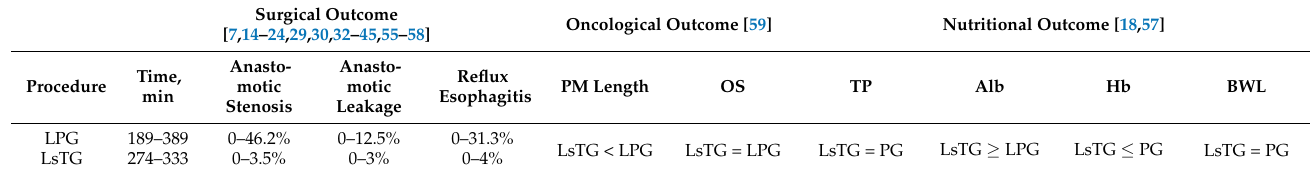
Table 5. Comparative outcomes of LPG and